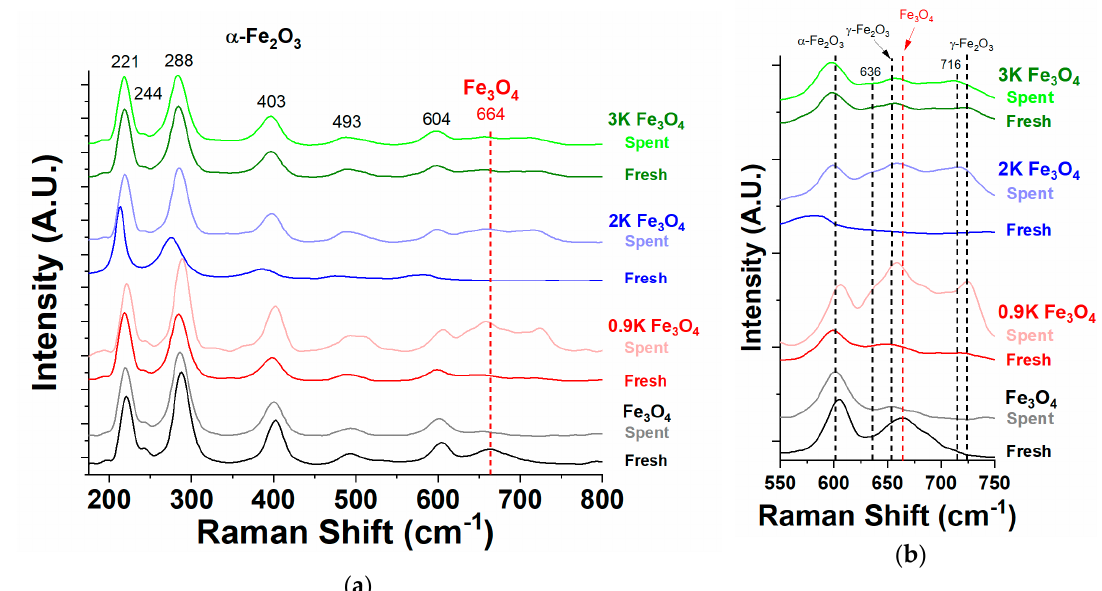
Figure 11. ( a ) Raman spectra of fresh and spent Fe 3 O 4 catalysts with varying K loading from 175 to 800 cm − 1 and ( b ) the same spectra zoomed in to the region from 550 to 750 cm − 1 . Drop lines are extended for reference to the assigned bands for Fe 3 O 4 , α -Fe 2 O 3 , γ -Fe 2 O 3 , and the bands at 636 and 716 cm − 1 are tentatively assigned to the potassium–iron oxide phase in K-containing samples.